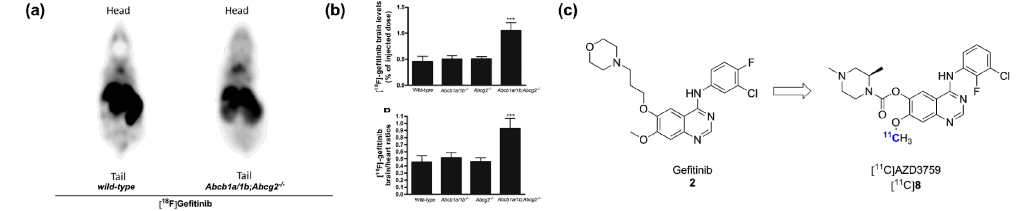
Figure 3. From gefitinib to AZD3759. ( a ) Representative PET images of [ 18 F]gefitinib in wild-type and Abcb1a/1b ; Abcg2 − / − mice; ( b ) Comparative quantitative results of brain uptake in wild-type, Abcb1a/1b − / − , Abcg2 − / − and Abcb1a/1b ; Abcg2 − / − mice (*** p < 0.0001, summed 30–60 min post i.v. [ 18 F]gefitinib injection) (Images in ( a , b ) adapted from [64] with permission from Elsevier); ( c ) Chemical structure of [ 11 C]AZD3759.